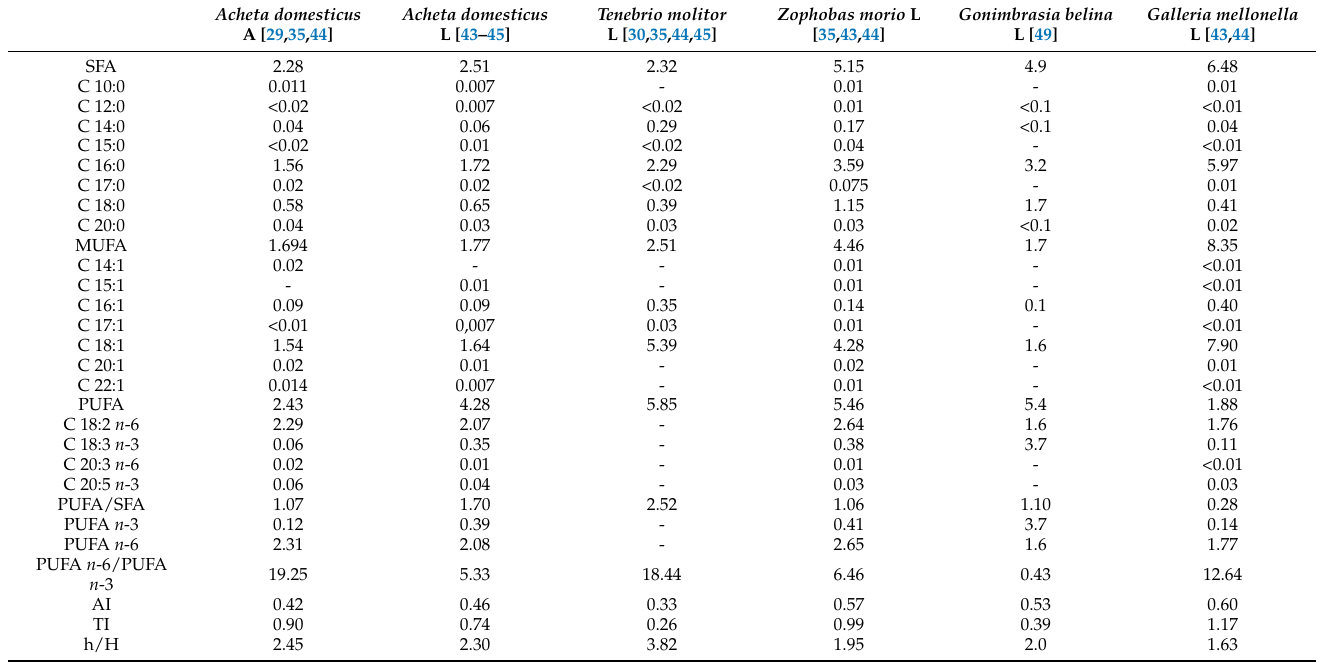
Table 5. Fatty acids content of edible insects (g/100 g edible portion)